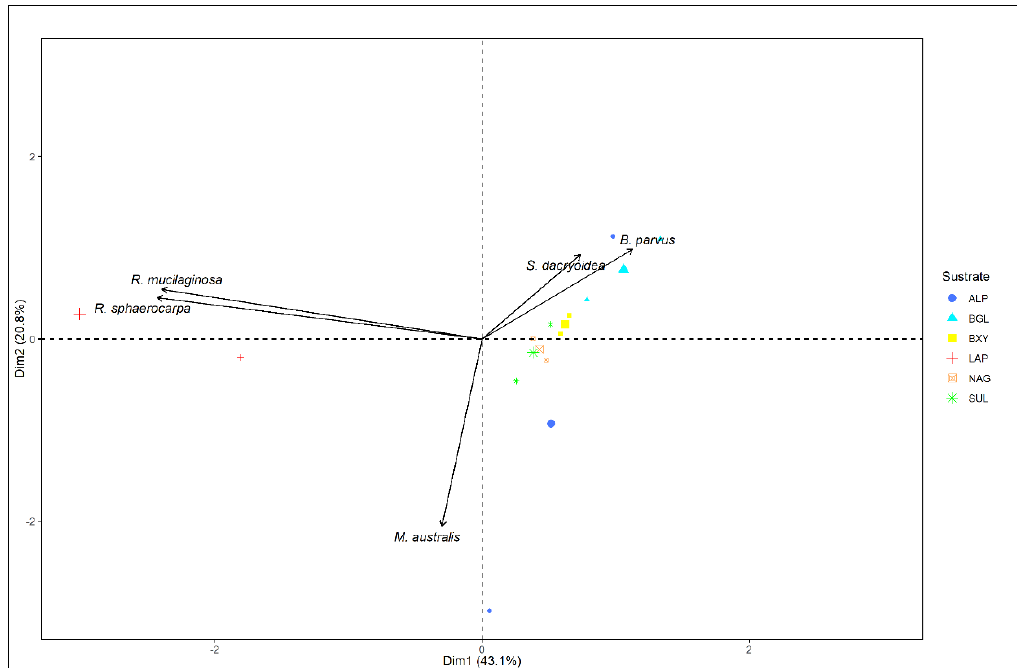
Figure 5. Q 10 of the normalized total enzymatic activity (V max ) with the biomass (dry weight) for the substrates β -glucosidase (BGL), β -xylosidase (BXY), N -acetyl- β -D-glucosaminidase (NAG), leucine aminopeptidase (LAP), alkaline phosphatase (ALP), and sulfatase (SUL) and the species B. parvus , M. australis , R. mucilaginosa , R. sphaerocarpa , and S. dacryoidea .